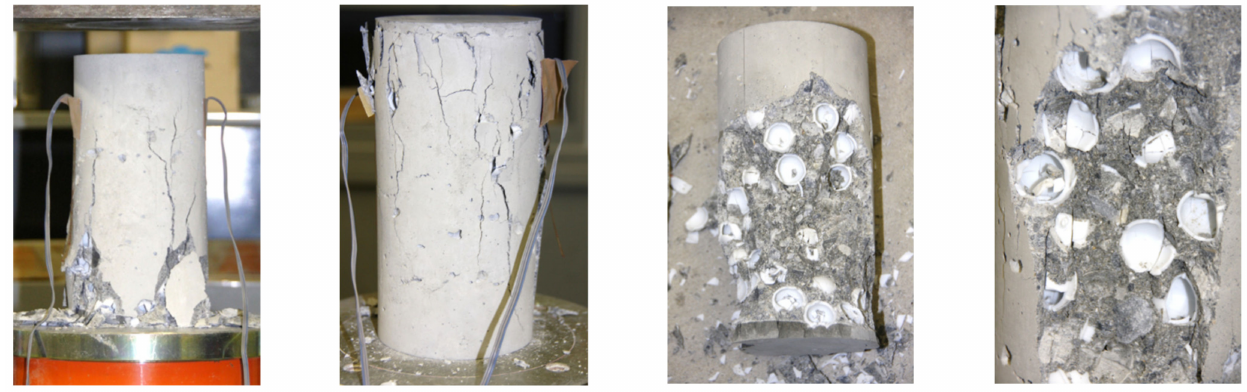
Figure 18. The failure picture of 2008 CS